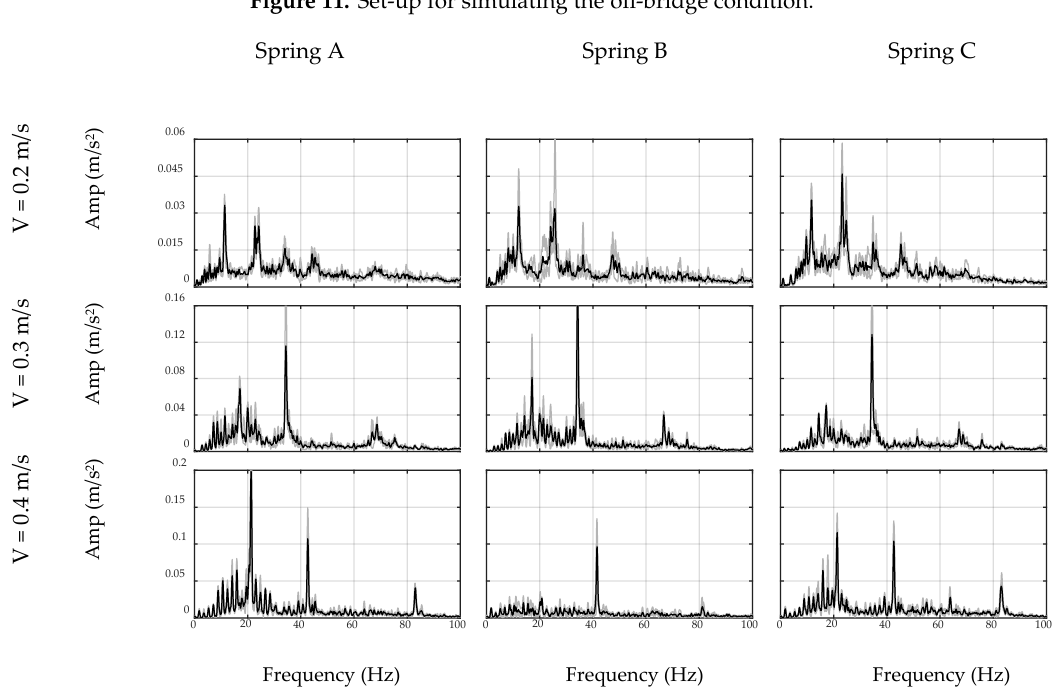
Figure 12. ADFT spectrums of off-bridge signals recorded by sensor.